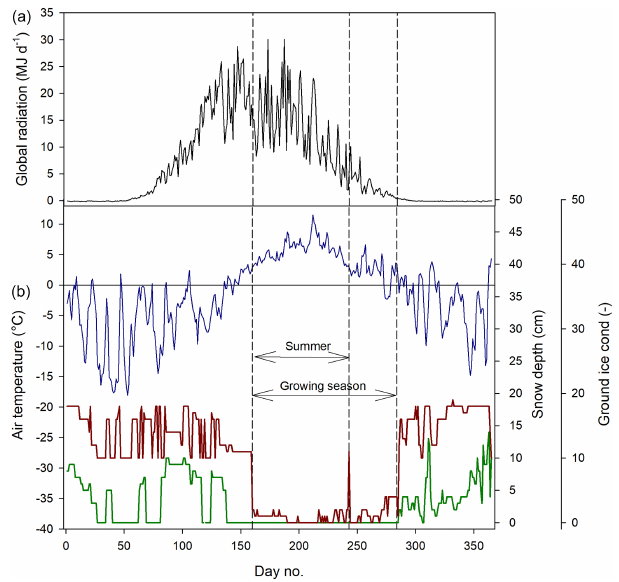
Figure 2. Weather conditions during 2015. (a) Mean daily global radiation at Adventdalen. (b) Mean daily air temperature at Isfjord Radio (blue), snow depth (red) and ground ice conditions (green) at Svalbard Airport close to Longyearbyen. The ground ice condition is scaled from 0–20, where 0 is no snow or ice on the ground and 20 indicates a complete cover of snow or ice.